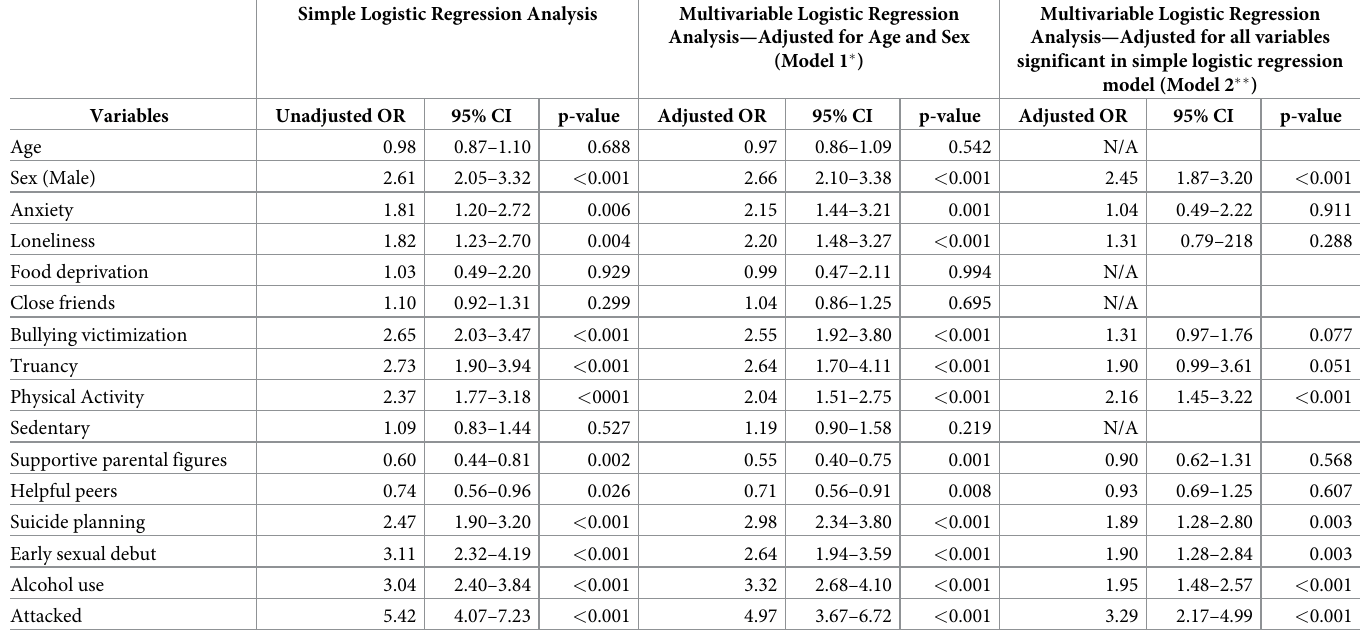
Table 3. Unadjusted odds ratios, adjusted odds ratios for age and sex, and adjusted odds ratios for all statistically significant variables for the association of physical fights with selected attributes among school-attending adolescents in Paraguay, GSHS 2017. Simple Logistic Regression